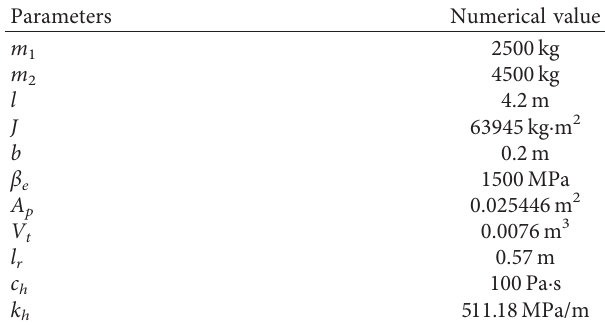
Table 1: Simulation